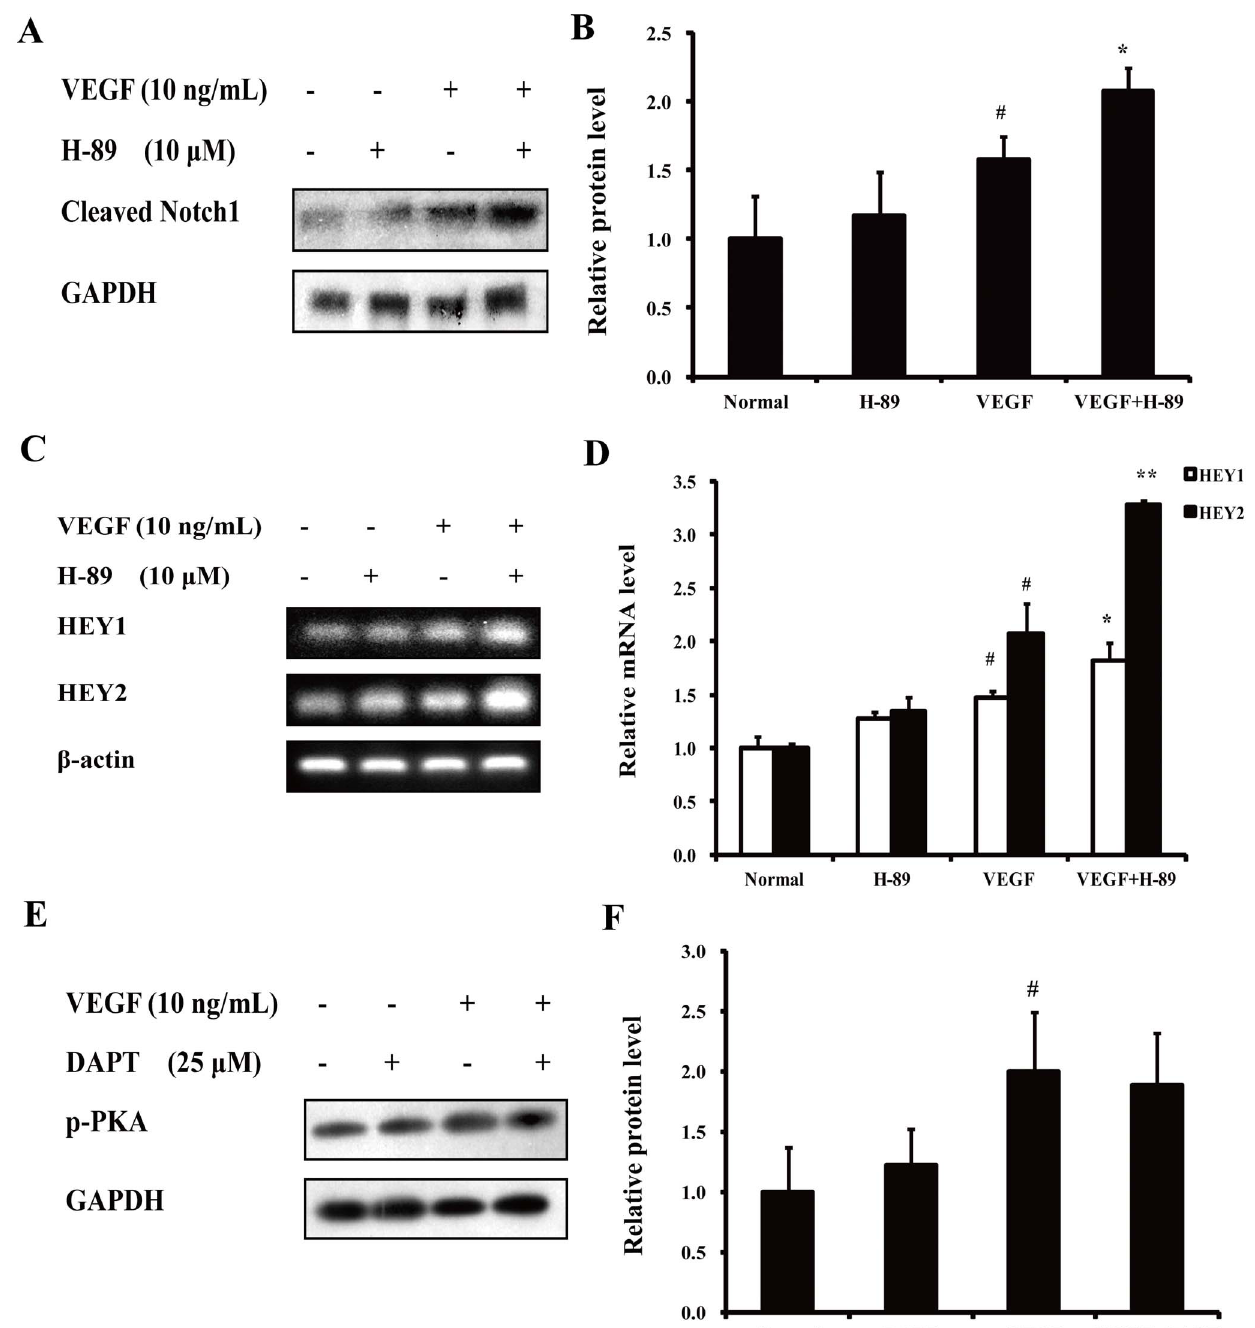
Figure 10. Interplay between PKA pathway and Notch1 pathway. ( A ). Effect of H-89 on VEGF-induced expression of Cleaved Notch1. ( B ). Quantification of Cleaved Notch1 expression. ( C ). Effect of H-89 on VEGF-induced HEY1 and HEY2 gene expressions. ( D ). Quantification of HEY1 and HEY2 gene expressions. ( E ). Effect of DAPT on VEGF-induced phosphorylation of PKA. ( F ). Quantification of PKA phosphorylation. The data were expressed as mean 6 SD of three independent experiments. # P , 0.05 vs . normal group; * P , 0.05, ** P , 0.01 vs. VEGF group. NOR, norisoboldine; Cur, curcumin.